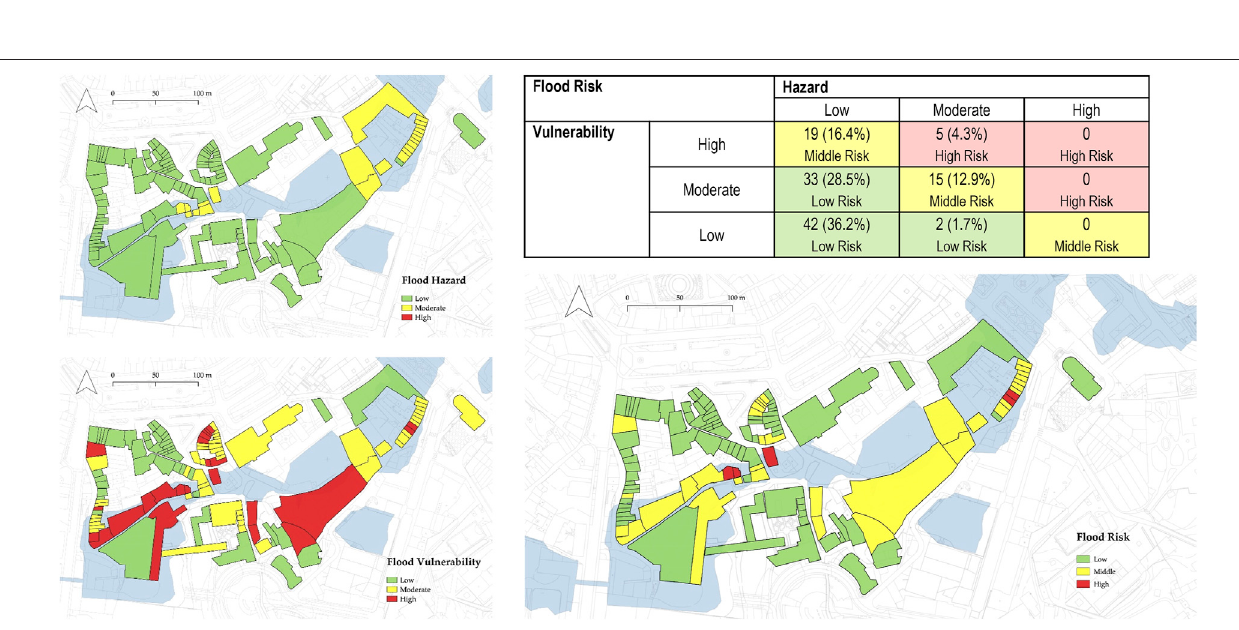
Frontiers in Earth Science |